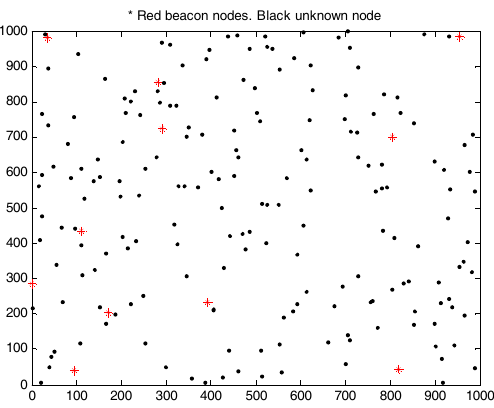
Figure 4. Node distribution with Beacons, where * represents the anchor node and ▪ represents the unknown node.